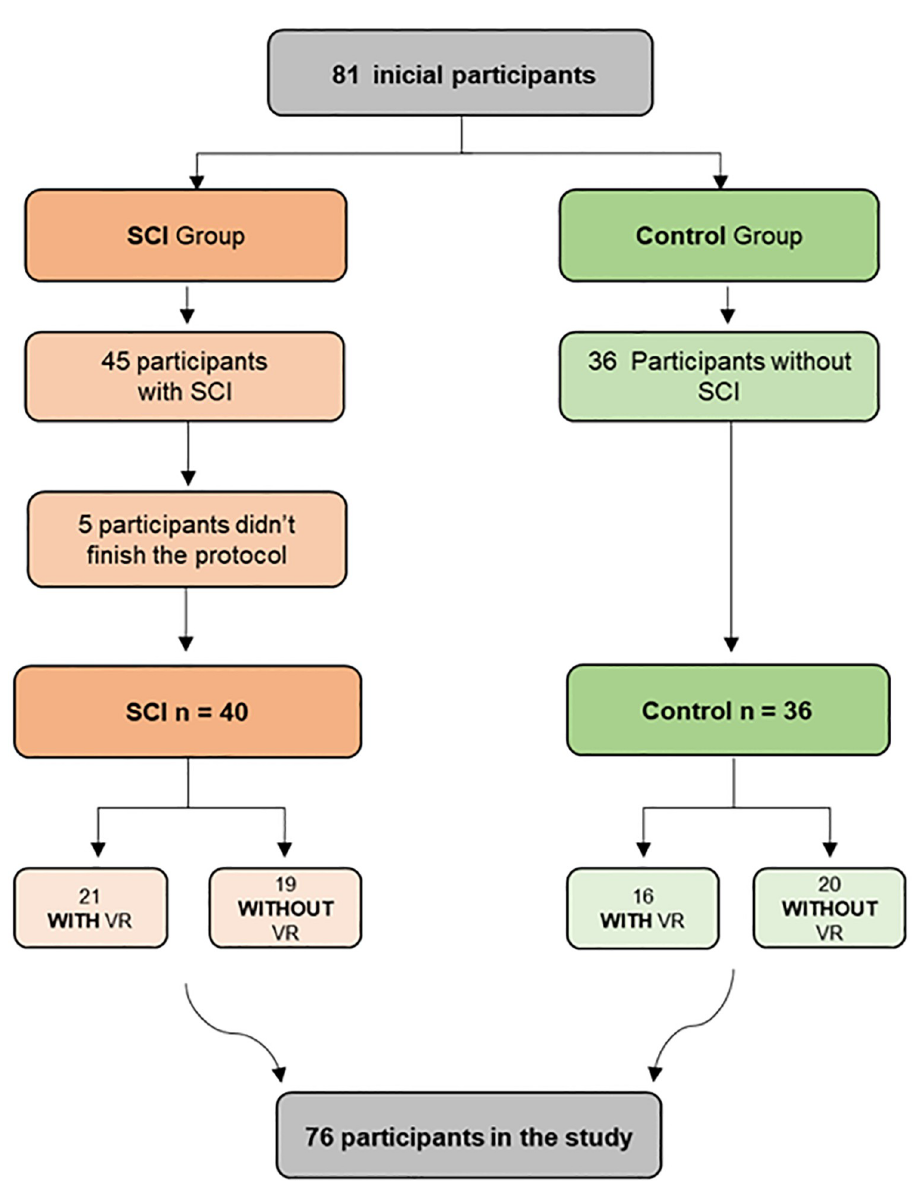
Fig 2. Flowchart. SCI: Spinal Cord Injury; VR: Virtual